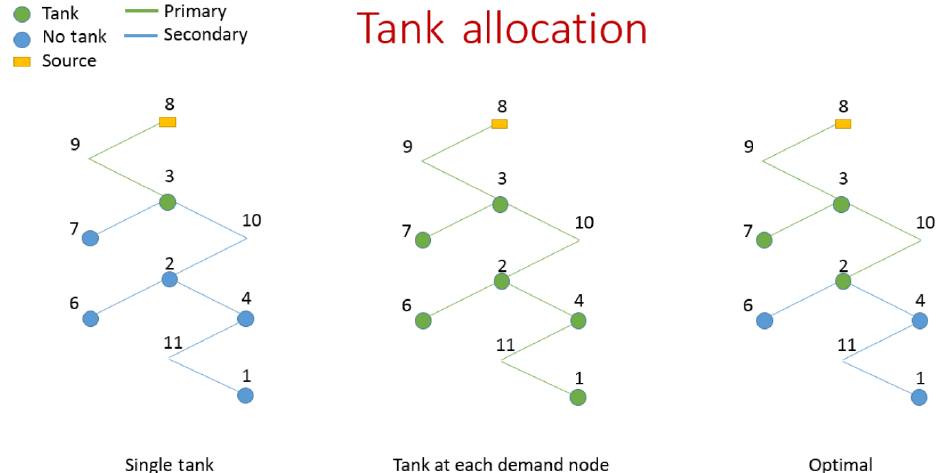
Figure 1. Alternate tank configurations for a sample